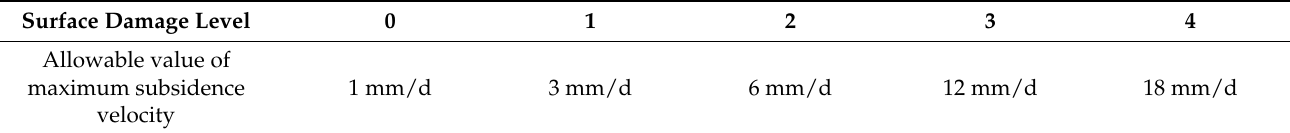
Table 1. Surface damage level and corresponding maximum allowable subsidence velocity values.